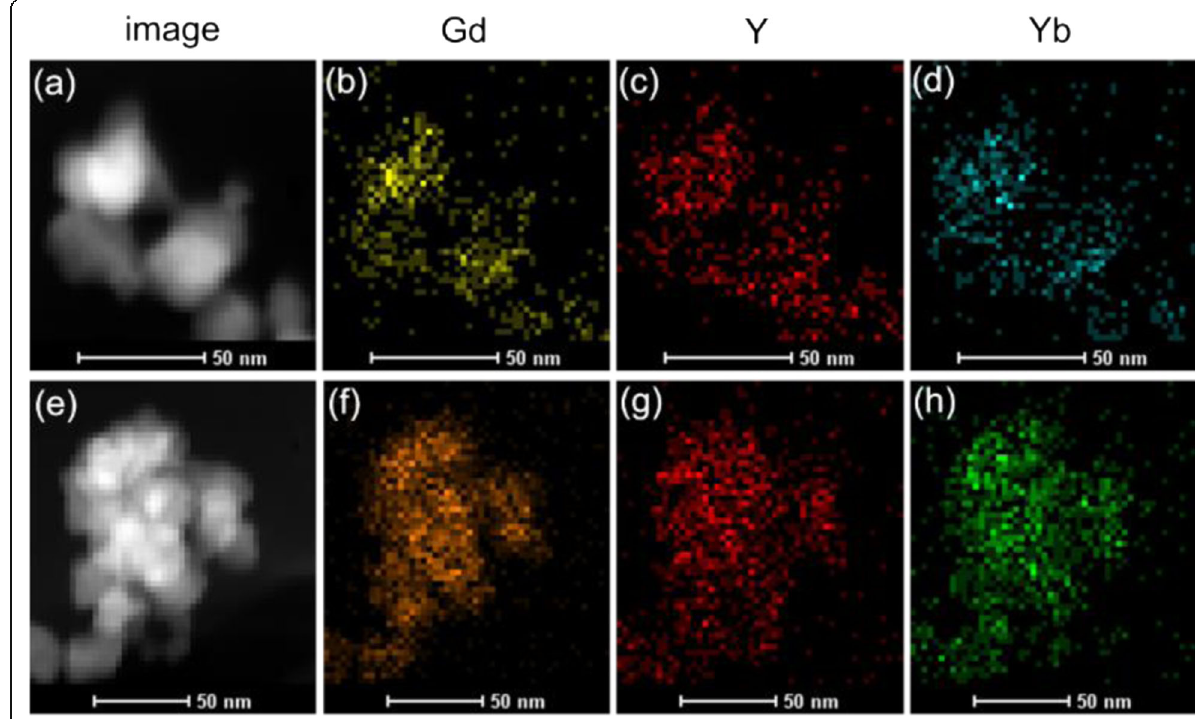
Fig. 6 Images of local elemental mapping by EDX line scans for a – d the 2-h-reaction NaGdF 4 /NaYF 4 :Yb,Er crystals and e – h the 6-h-reaction NaGdF